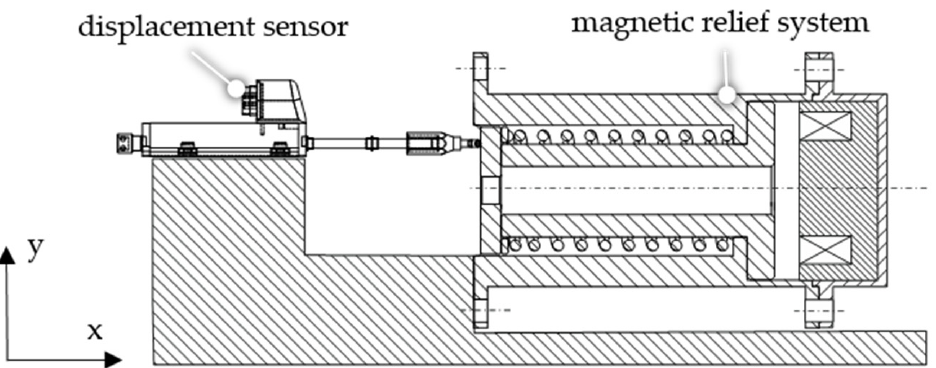
Figure 11. The systematical measuring set